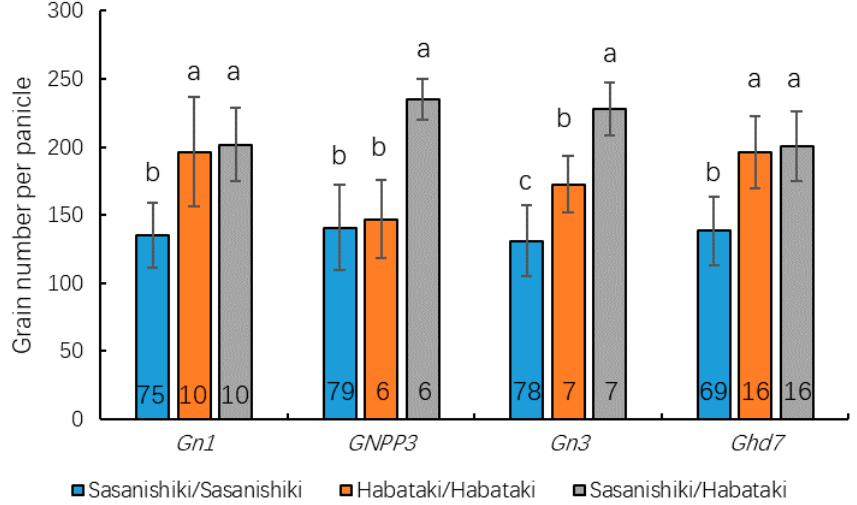
Figure 5. Grain number per panicle of each genotype for the four QTLs detected in BIL and BILF 1s . The number inside the column represents the number of plants for each genotype. All data are given as mean ± s.e.m. , different letters indicate the significant differences at the 5% level.